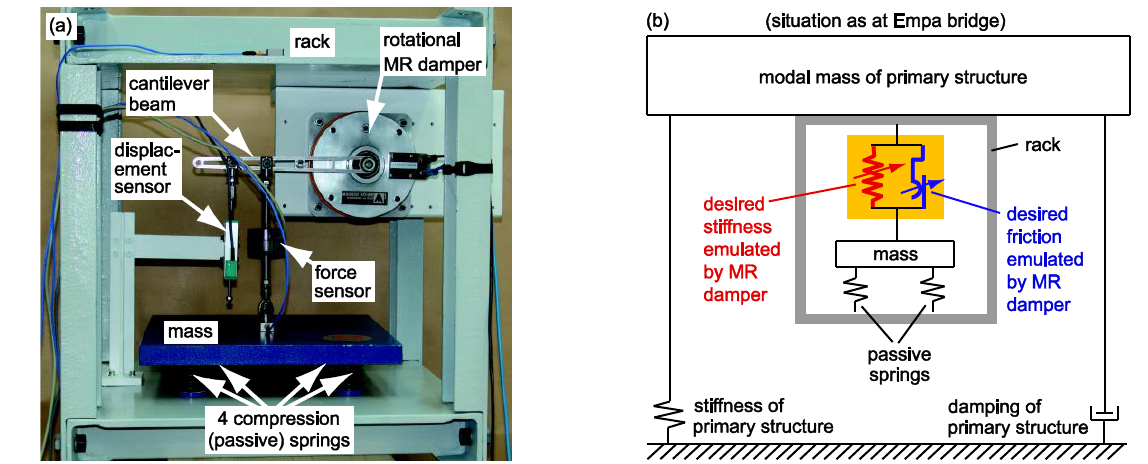
Figure 10. ( a ) Photograph and ( b ) sketch of prototype MR-SVA for laboratory scale bridge.